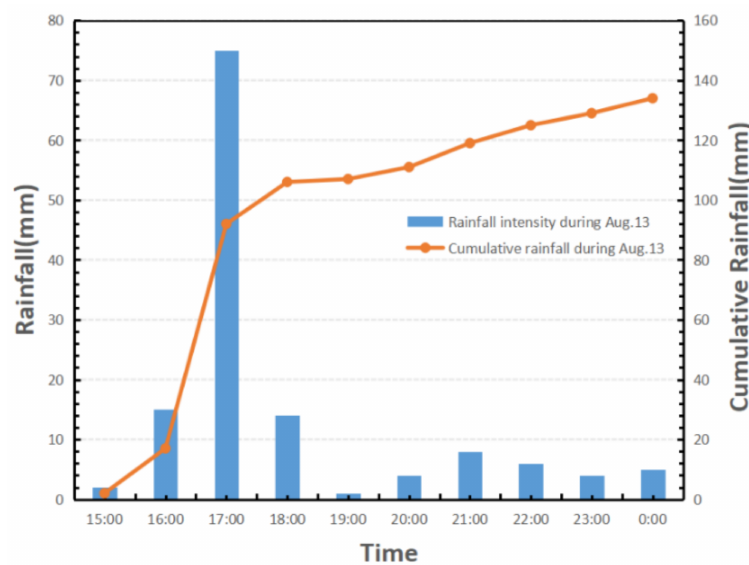
Figure 5. Rainfall data on 13 August